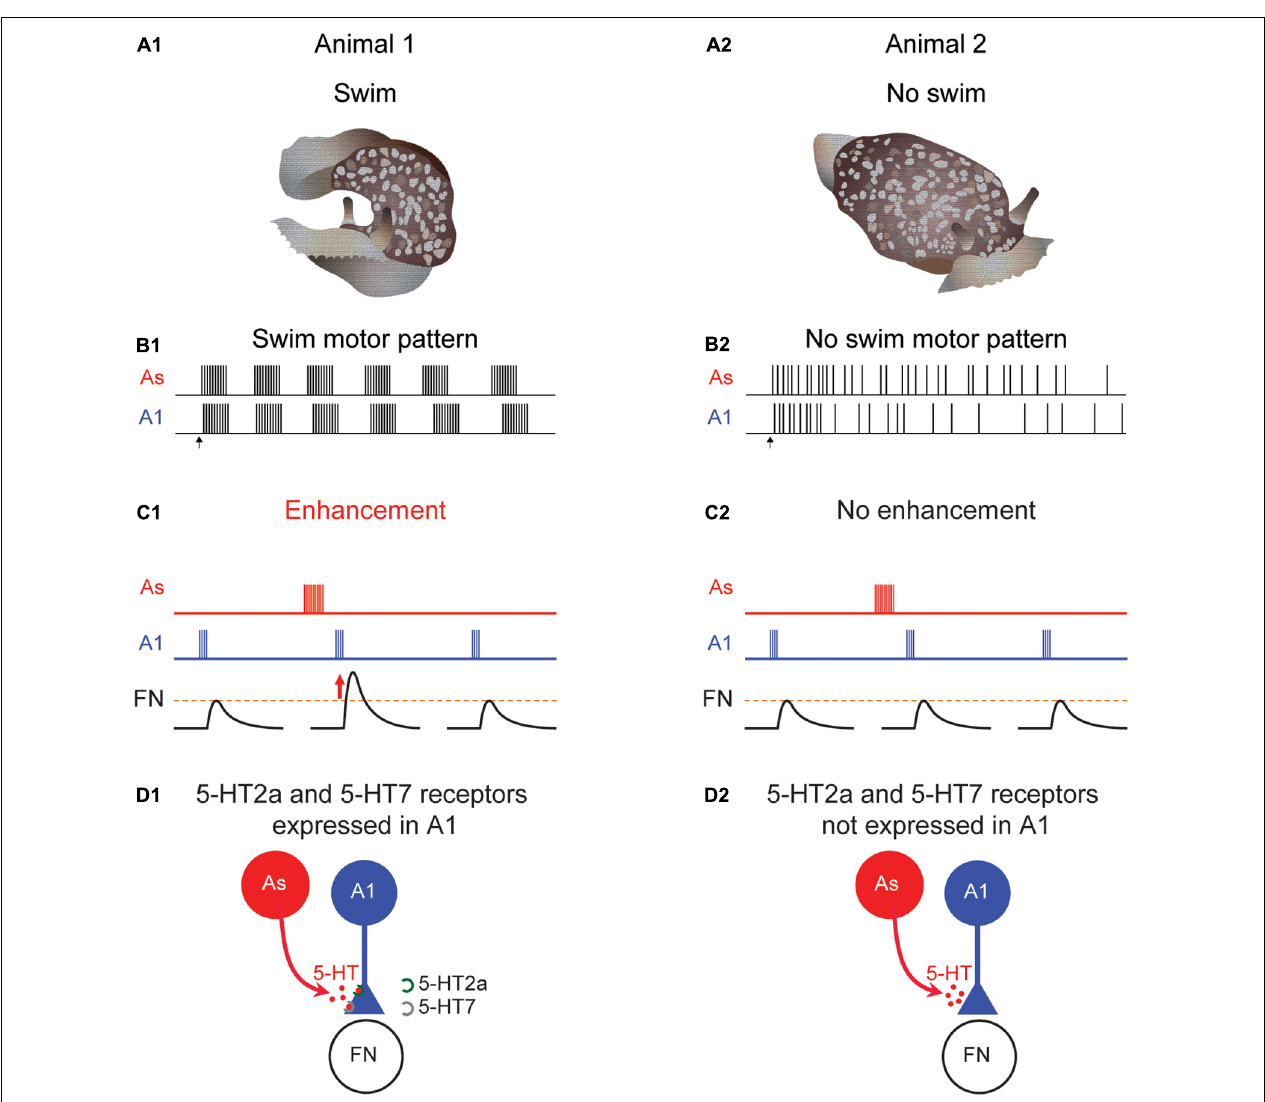
FIGURE 4 | Differences in Pleurobranchaea swimming, neuromodulation, and serotonin receptor expression. When tested, some animals swim (A1) produce a rhythmic swim motor pattern (B1) . At other times, an animal might not swim (A2) and would not produce a swim motor pattern (B2) . When the animal swims the A1 to follower neuron (FN) synapse is strengthened following serotonergic As stimulation in a swimming animal (C1) . But at times when the animal does not swim, there is no enhancement (C2) . Serotonin receptor subtypes 5-HT2a and 5-HT7 are present in preparations that produce a swim motor pattern (D1) but not in ones that do not (D2)